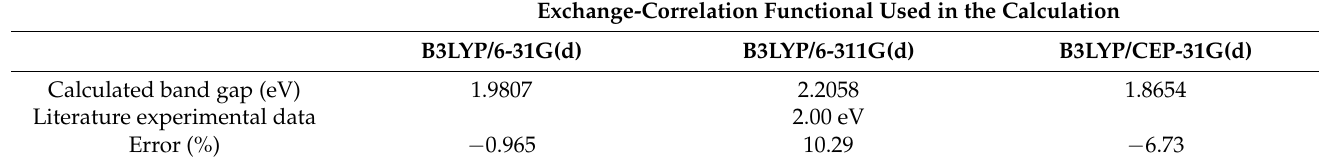
Table 3. Calculated and experimental band gaps of T ∞ . Experimental results are drawn from the literature [23]. Error was calculated by ((C − E)/E) × 100%. Where C is the calculation result and E is the experimental